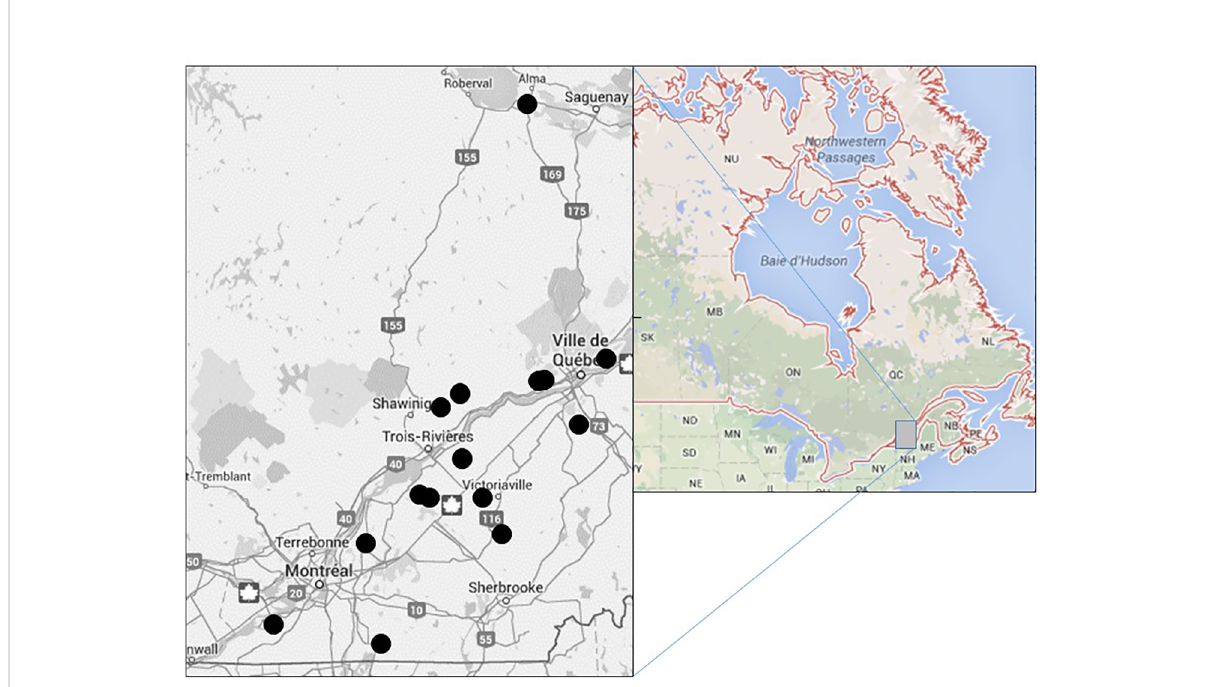
FIGURE 1 Location of fi eld pairs (black circles, left map) and sampling area in Canada (grey square, right